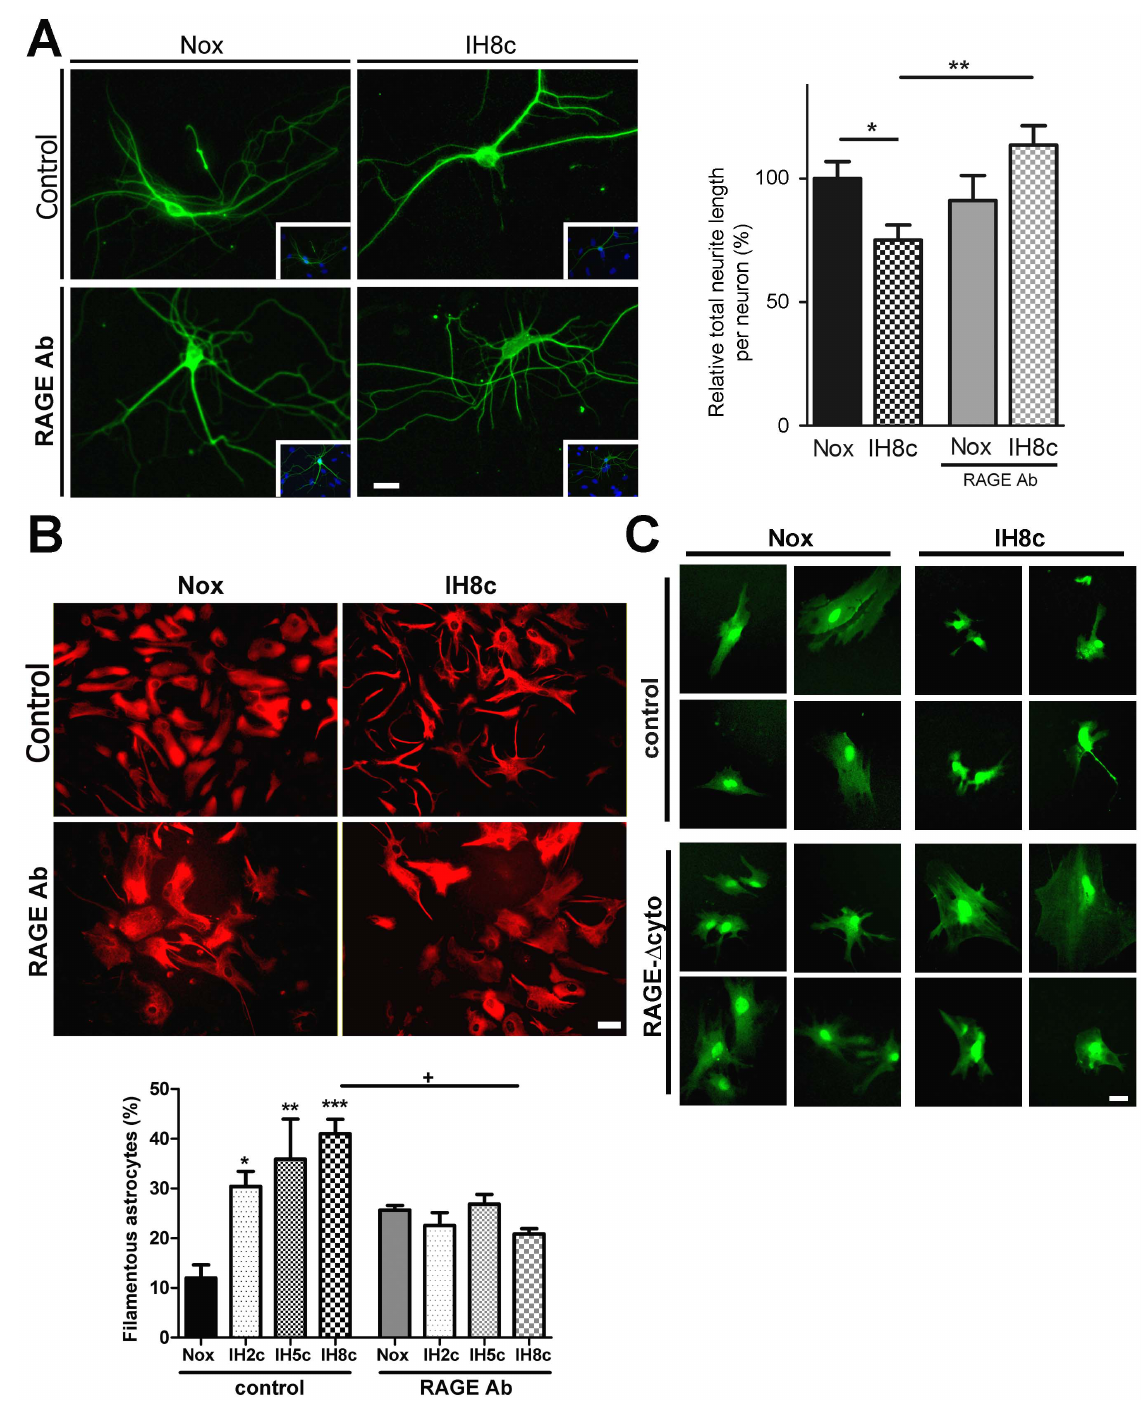
Figure 4. RAGE is required for the neuronal alterations and astroglial stellation induced by IH exposure in the dissociated mixed hippocampal cell culture. A: b III-Tubulin immunostained hippocampal neurons in dissociated mixed hippocampal cell culture after 8 cycles of IH exposure (IH8c) or normoxia (Nox) in the absence and presence of RAGE blocking antibodies (1 m g/ml), bar =14 m m (left). Quantitative analysis of relative neurite length per neuron in a similar experiment (right). B: GFAP immunostained astrocytes in dissociated mixed hippocampal cell culture after 8 cycles of IH exposure (IH8c) or normoxia (Nox) in the absence or presence of RAGE blocking antibodies, bar =14 m m (top). Quantitative analysis of the percentage of filamentous astrocytes (bottom). C: Astrocytes infected with the HSV-derived amplicon driving the expression of RAGE D cyto and GFP, or control amplicon expressing only GFP, exposed to 8 cycles of IH exposure (IH8c) or normoxia (Nox), bar =12 m m. Data on the graphs are shown as means 6 SEM; significance vs. control group was represented as indicated: * p , 0.05; **p , 0.01; *** p , 0.001 after two way ANOVA and Bonferroni post-test.